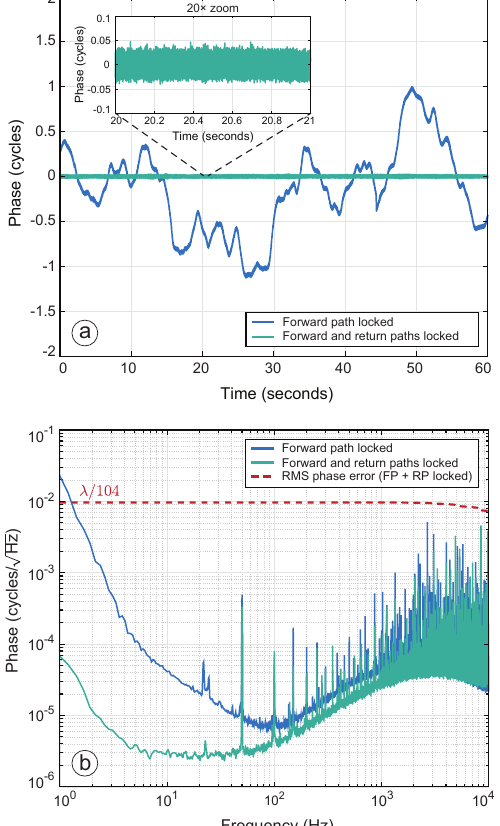
Figure 13. ( a ) Time series measurements of φ OOL when the OPA is forward path-locked (blue), and fully locked (green) using DEHI with a 15-bit PRBS. The inset shows the zoomed-in behaviour of φ OOL when fully locked. ( b ) RPSD of the measurements shown in ( a ). The harmonic distortion visible in ( b ) is caused by residual PRBS noise introduced by the decoder. The RMS phase error was calculated to be Φ RMS = λ /104 at 1 Hz, limited by harmonic distortion introduced by imperfect decoding of the 15-bit